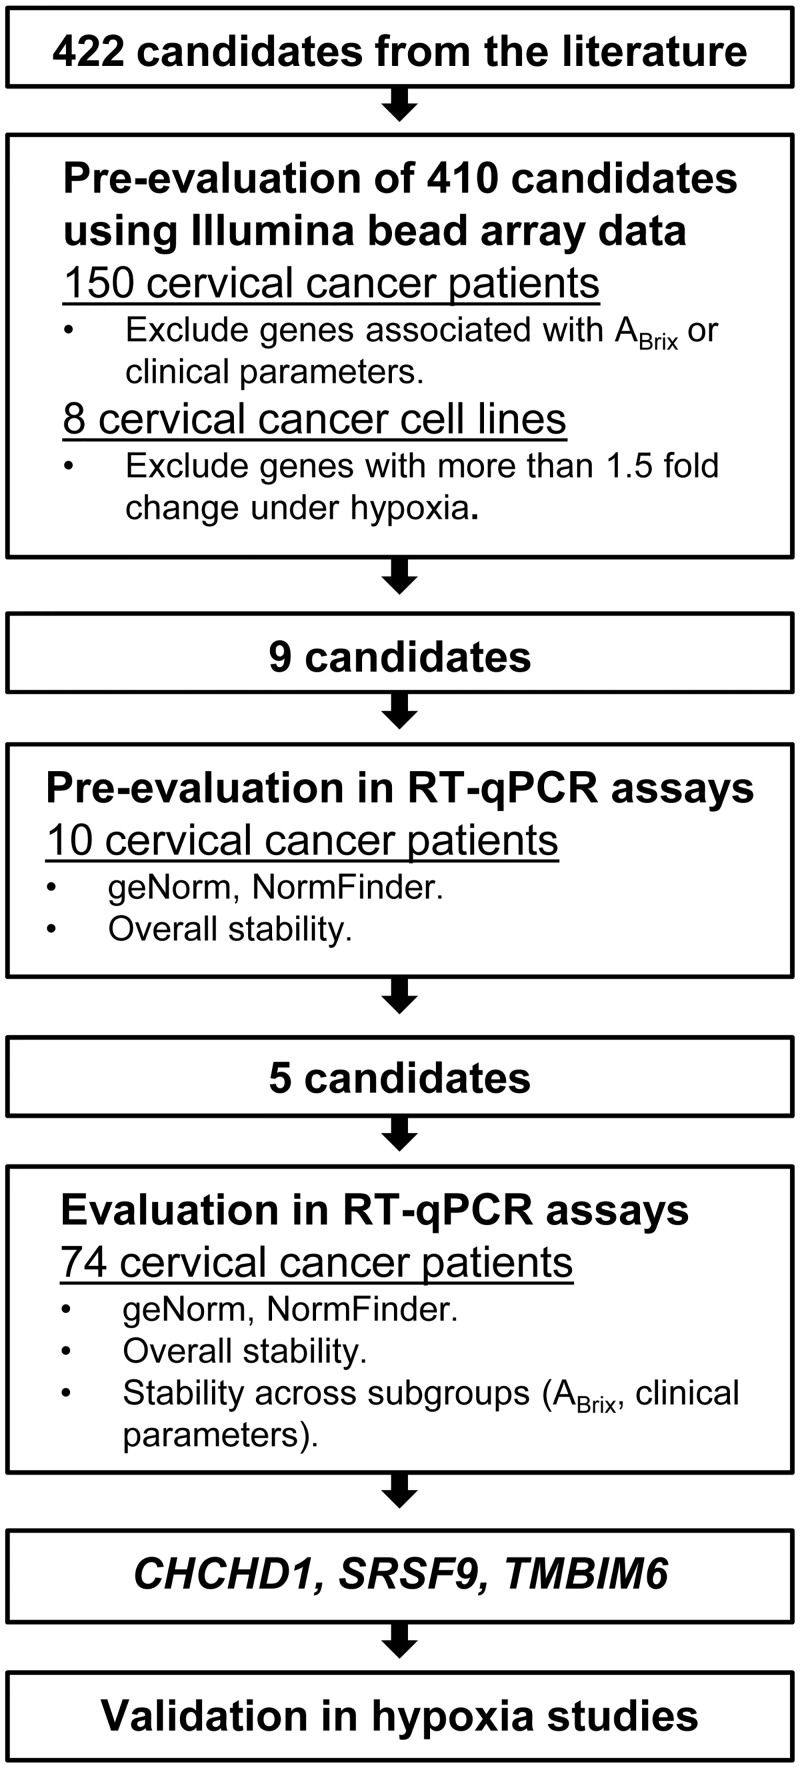
Overview of the study.